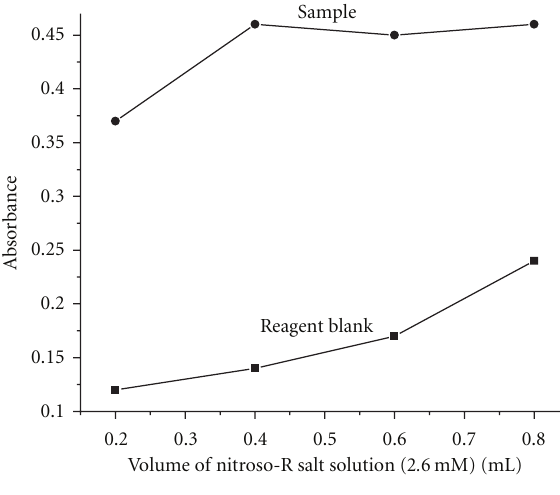
Figure 4: E ff ect of nitroso-R